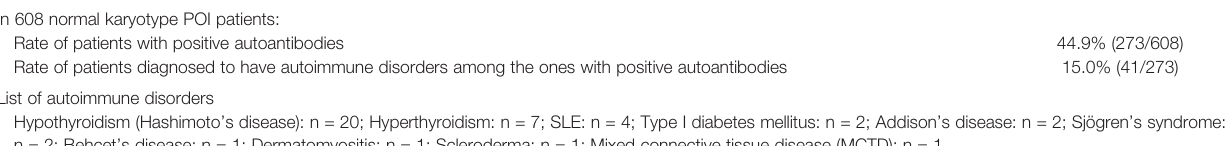
TABLE 3 | Autoimmune disorders in POI cases (St. Marianna University School of Medicine and the Rose Ladies Clinic) (11). In 608 normal karyotype POI patients: Rate of patients with positive